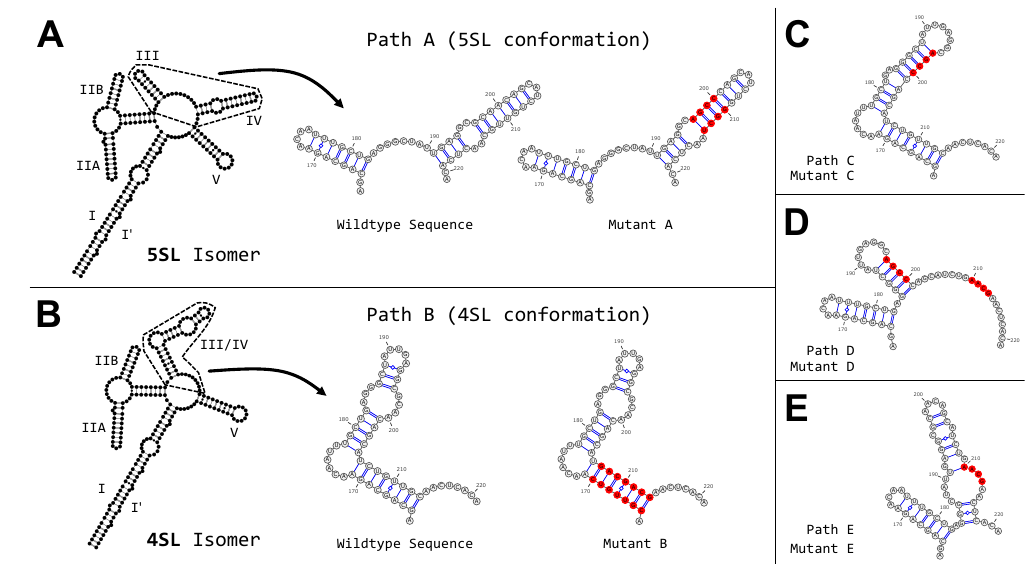
Figure 3. Predicted secondary structure of the Rev response element (RRE). ( A ) Full-length predicted structure of the five stem-loop (5SL) isomer of RRE. Stem-loops are indicated by their numeral. The region of interest (SL III/SL IV) is indicated with dashed lines, and expanded to show base pairings. The structure of RRE Mutant A, a variant of RRE that prefers the 5SL conformation, is also shown. ( B ) Full-length predicted structure of the four stem-loop (4SL) isomer of RRE along with a similar comparison as made in ( A ). Shown to the right is the structure of Mutant B, an RRE variant preferring the 4SL conformation. ( C – E ) Predicted secondary structure of the SL III/IV region for three additional RRE mutants. All mutants were produced by Sherpa et al. [56] with induced mutations highlighted in